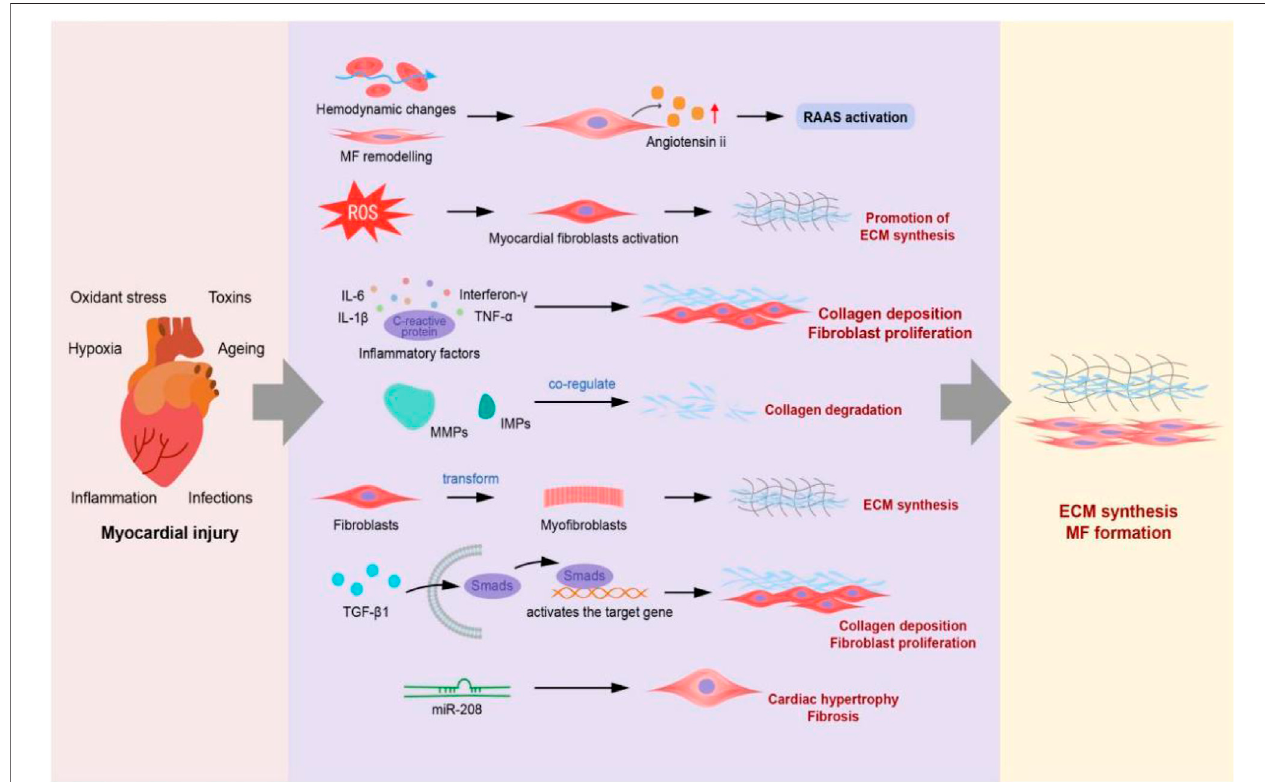
FIGURE 1 | Mechanisms of myocardial fi brosis (The RAAS, oxidative stress, immune in fl ammatory mechanisms, matrix metalloproteinase system, fi broblast overproliferation, and TGF- β 1/Smad3 signalling pathway lead to ECM deposition and sustained myocardial fi brosis).